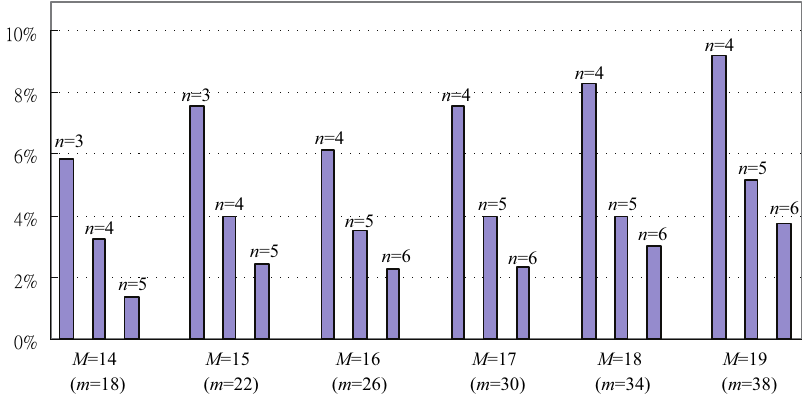
Fig. 3 Numerical results of wastage (%) for six main test